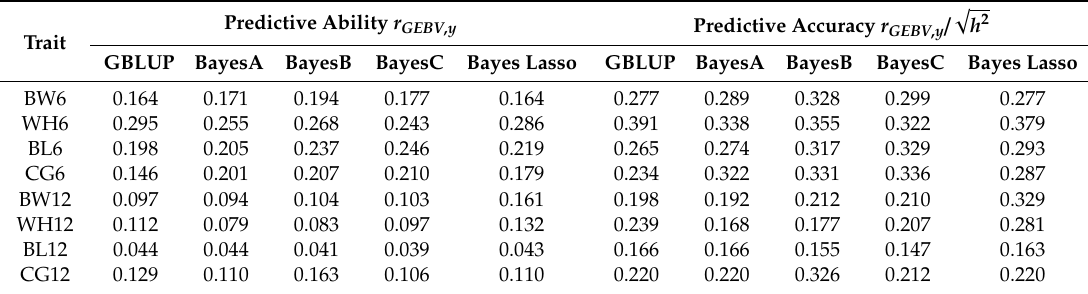
Table 3. Predictive ability and accuracy of early growth traits for two developmental stages using five statistical methods with five-fold